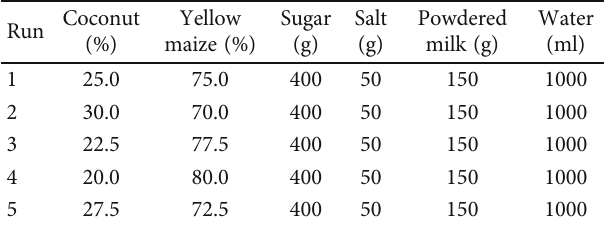
Table 1: Formulations for the ready-to-eat breakfast